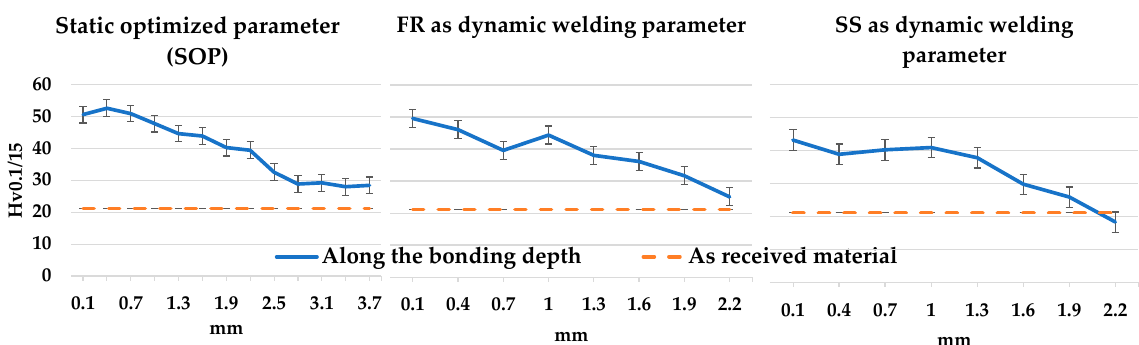
Figure 14. Microhardness results along the bonding depth direction. The error bars show the maximum and the minimum value of the measurements.